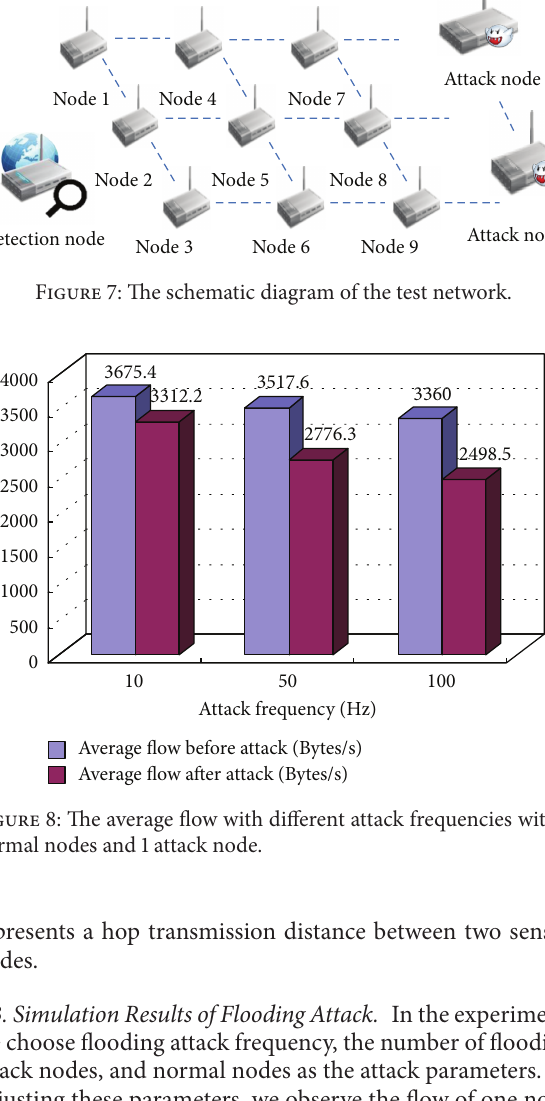
represents a hop transmission distance between two sensor